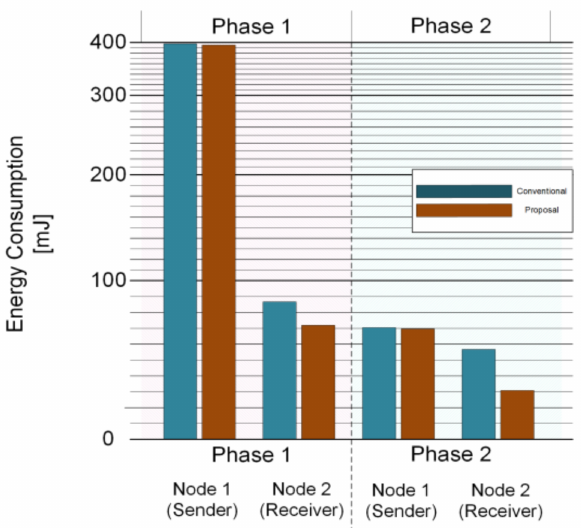
Figure 13. Comparison of node energy consumption for each communication